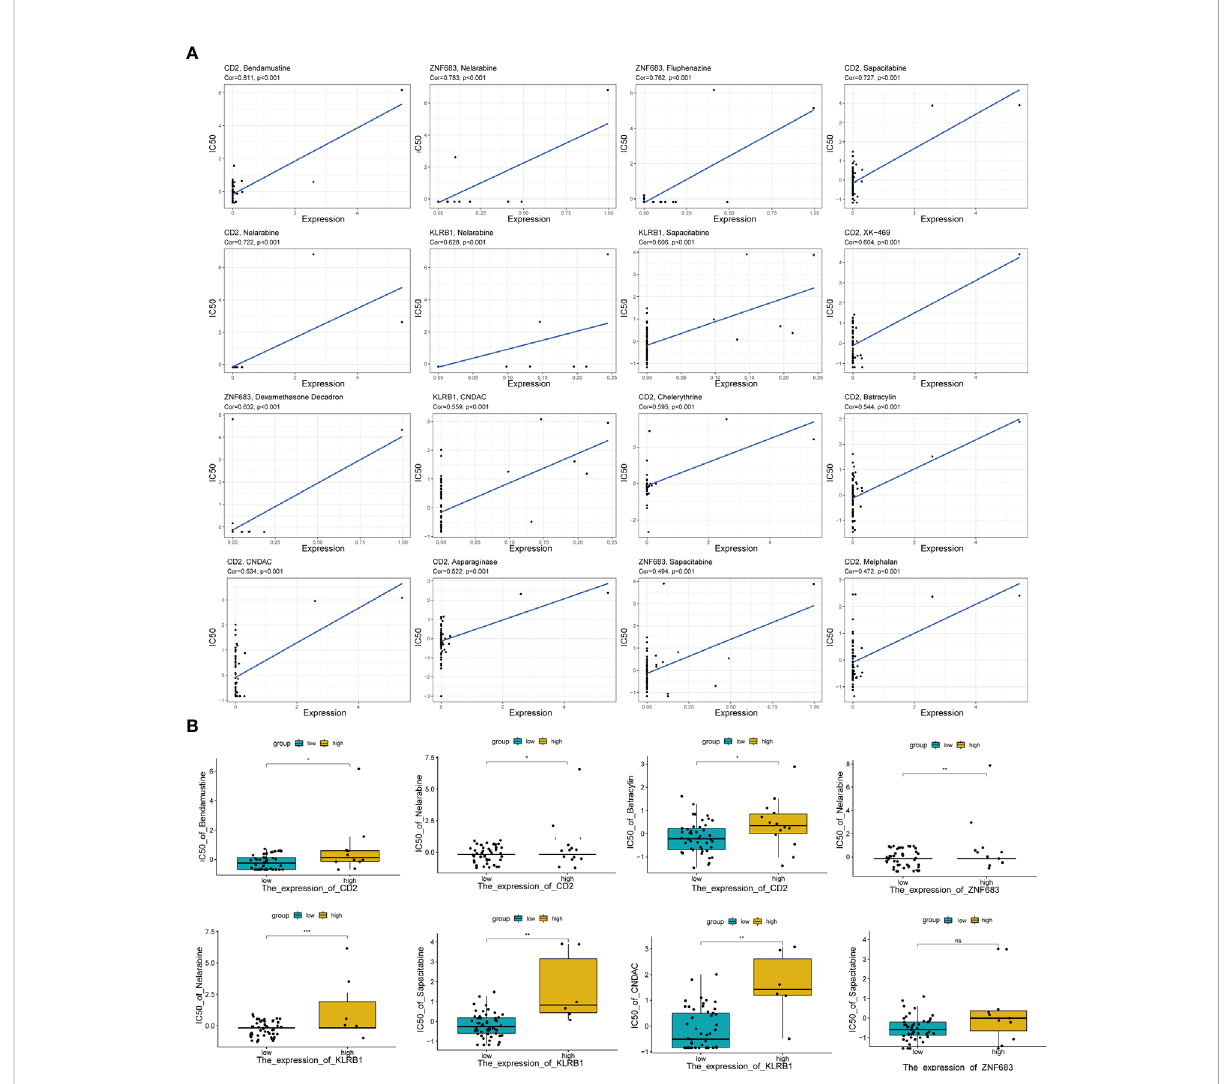
FIGURE 5 (A) The correlation analysis between expression levels of CD2 , ZNF683 and KLRB1 with IC50 of anti-tumor drugs. (B) Boxplot showed IC50 difference of anti-tumor drugs in high-/low-expressed subgroups for CD2 , ZNF683 and KLRB1 . IC50, the half maximal inhibitory concentration *p < 0.05, **p < 0.01, ***p <